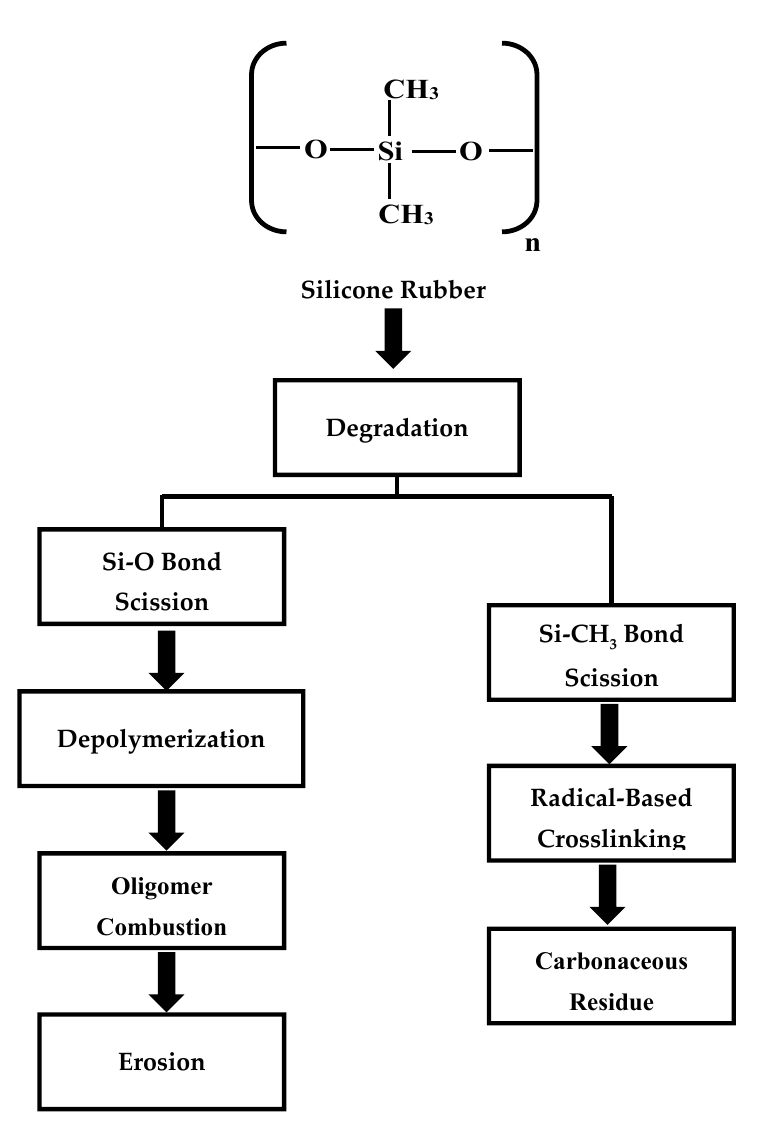
Figure 3. Thermal degradation mechanisms promoting carbonaceous residue and erosion of silicone rubber outdoor insulation.